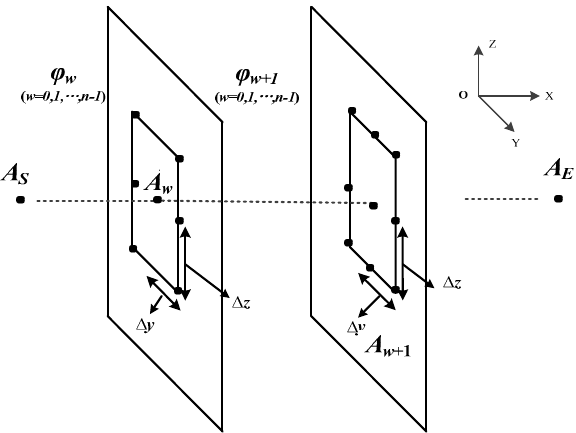
Figure 3. Path selection process. Set the robot’s mobile unit to be 1 grid along the Y -axis and Z -axis. ∆ y = ± 1 m and ∆ z = ± 0.5